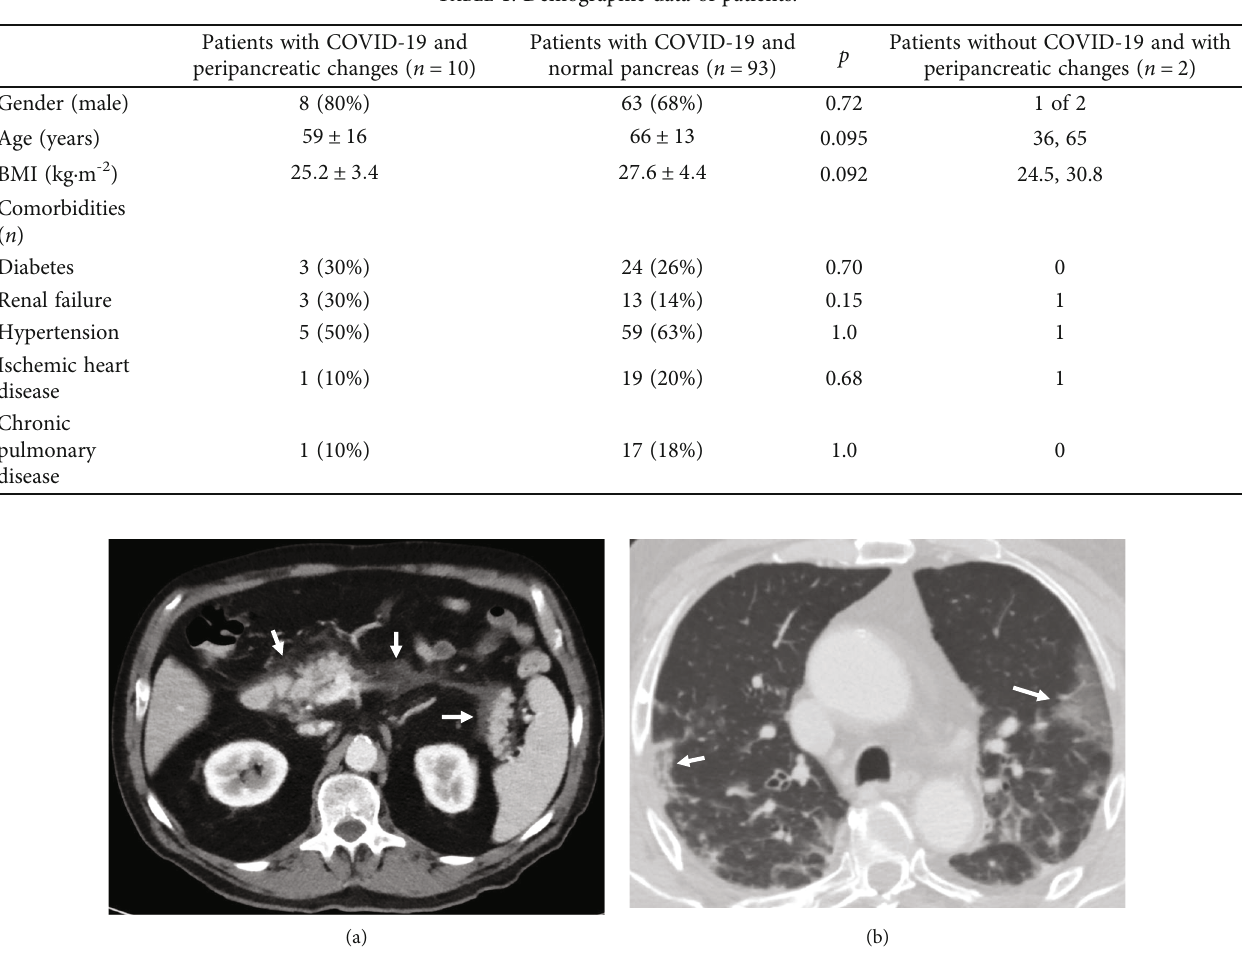
Figure 2: Acute peripancreatic fl uid collection (a) in a patient with COVID-19 infection and pulmonary involvement